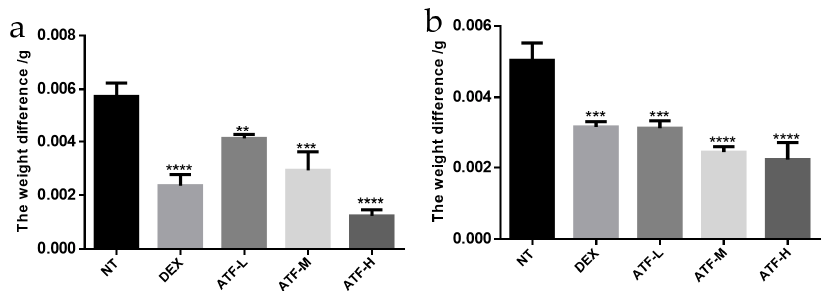
Figure 6. The effects of ATF on xylene-induced ear swelling and cotton ball granuloma in mice. ( a ) Inhibitory effect of ATF on xylene-induced ear swelling in mice. ( b ) Inhibitory effect of ATF on cotton ball granuloma in mice. NT: no treatment model group, DEX: dexamethasone (5 mg/kg) treatment group, ATF-L: ATF 100 mg/kg, ATF-M: ATF 500 mg/kg, ATF-H: ATF 1000 mg/kg. Data are expressed as mean ± SD. ** p < 0.01, *** p < 0.001, **** p < 0.0001 compared with the NT group.